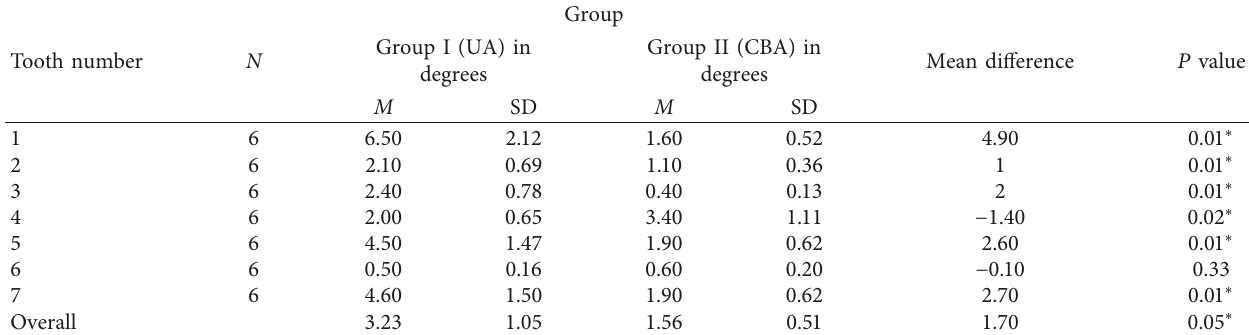
Table 3: Tipping (angular) deviation of orthodontic